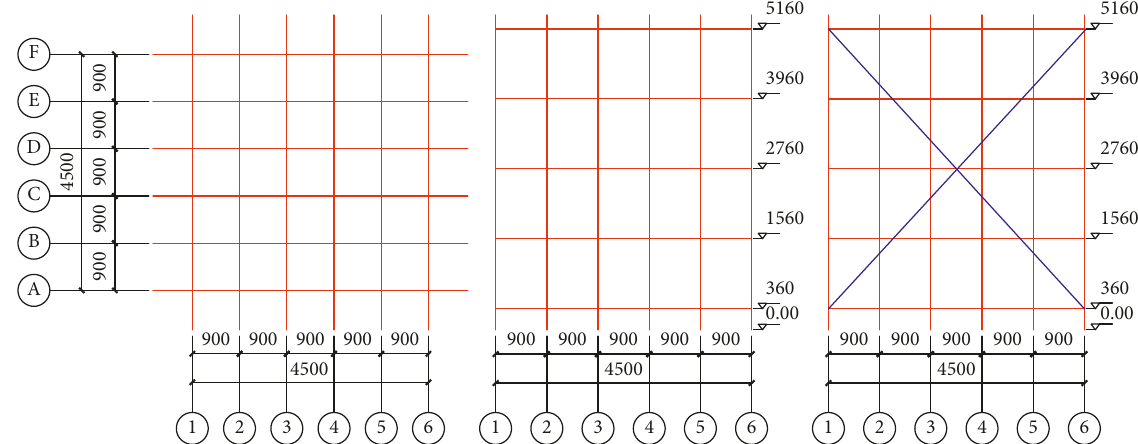
Figure 4: Structural layouts of Models 4 and 5. (a) Plane view. (b) Vertical view of Model 4. (c) Vertical view of Model